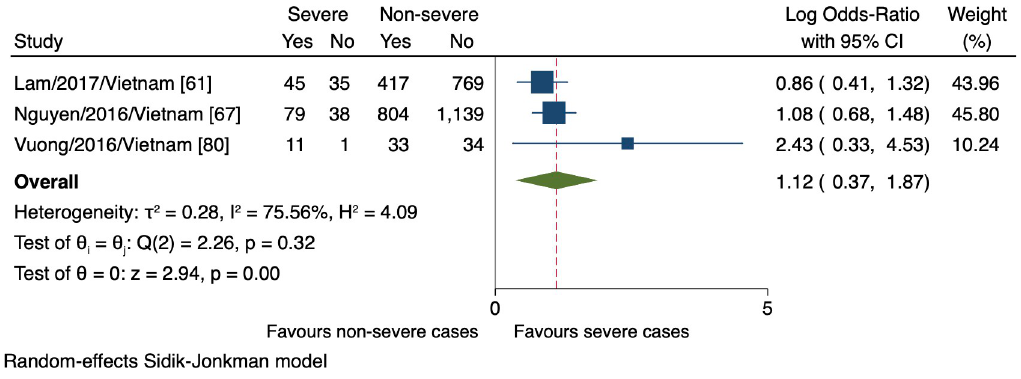
Fig 5. Forest plot showing the relationship between vomiting and severe dengue. The red dashed line represented the overall effect size.